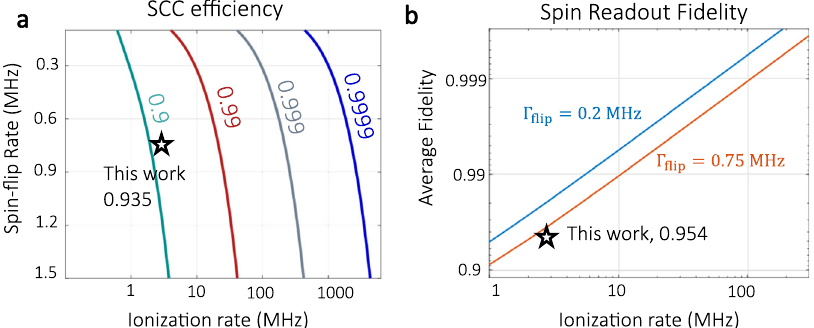
Fig. 4 Exceeding the 99.9% fault-tolerant threshold. a Effects of ionization rate and spin- fl ip rate on SCC ef fi ciency, which is indicated by the number next to each curve. b Dependence of overall spin readout fi delity on ionization rate at two different spin- fl ip rates. The orange line corresponds to spin- fl ip rate observed in this work. The blue line is a prediction for an NV center with a low spin- fl ip rate reported in ref. 7